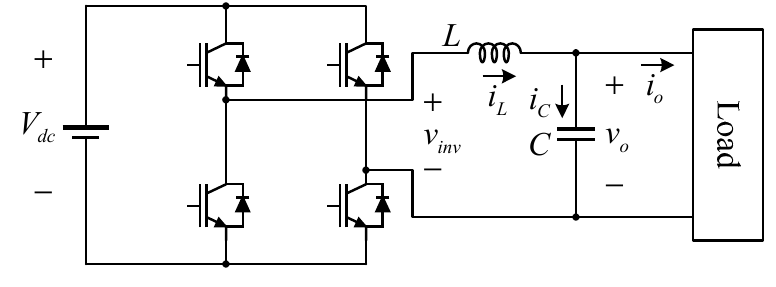
Figure 1. Single-phase UPS inverter system.